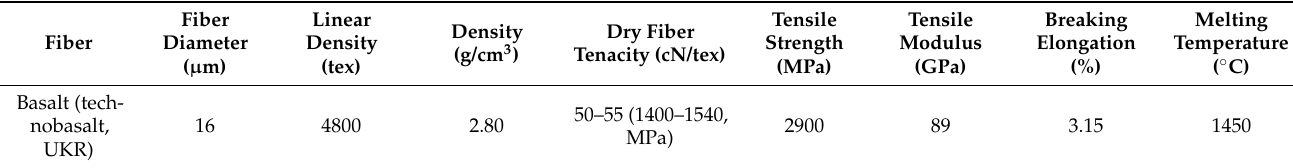
Table 1. The continuous basalt TOW properties used in basalt fiber concrete composites [87,88]. Fiber Fiber Diameter Basalt (tech-